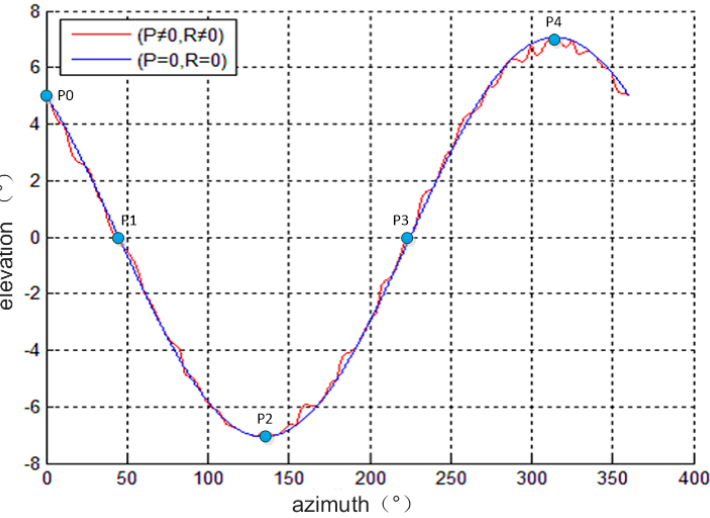
′Δ ∆ h (cid:48) curve. Figure 5. The effect of hull roll and pitch on the elevation error